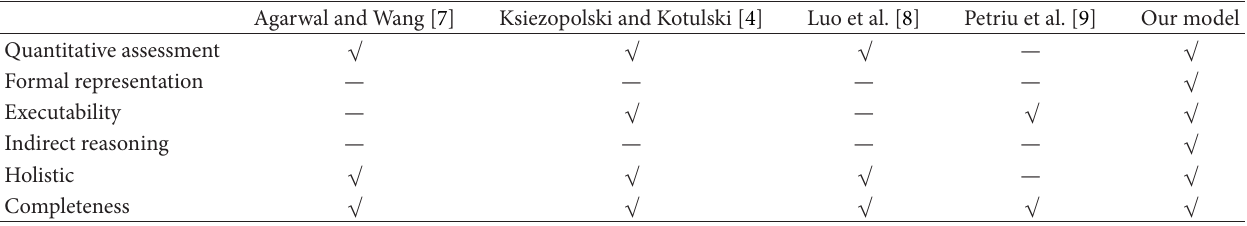
Table 11: The characterization of the security mechanisms evaluation models. Agarwal and Wang